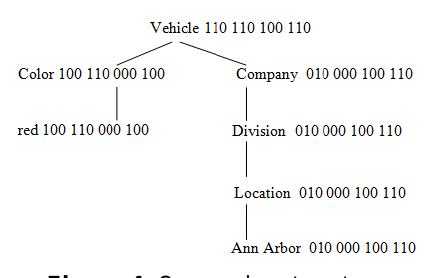
Figure 4 . Query signature tree